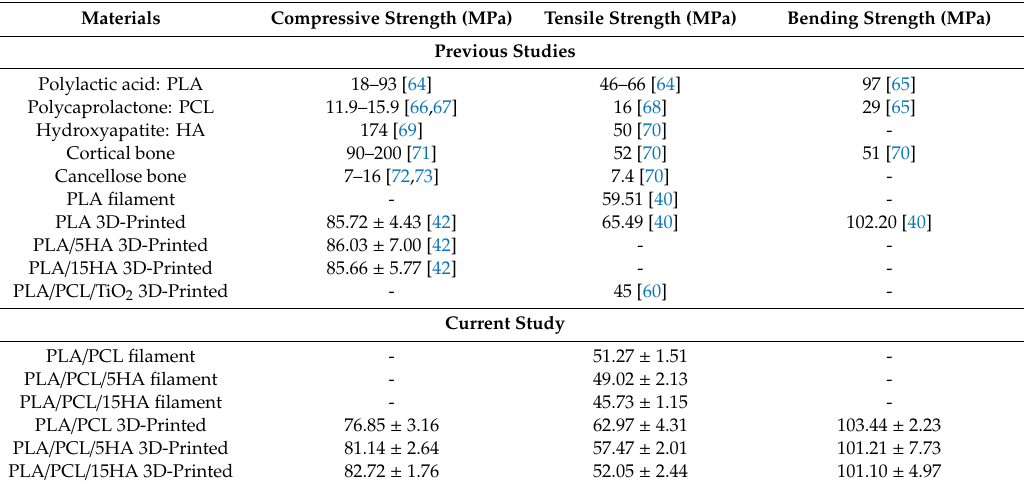
Table 8. Mechanical properties of the